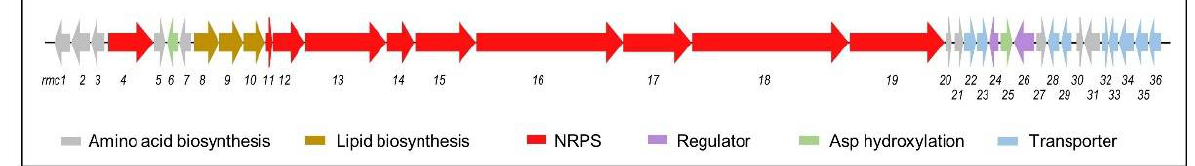
Figure 7. Rumycin ( rmc ) biosynthetic gene cluster.